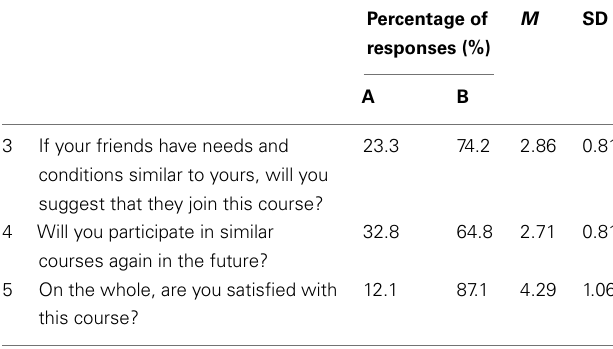
Table 5 | Other aspects of subjective outcome evaluation . Table 6 | Changes in new participants based on the different